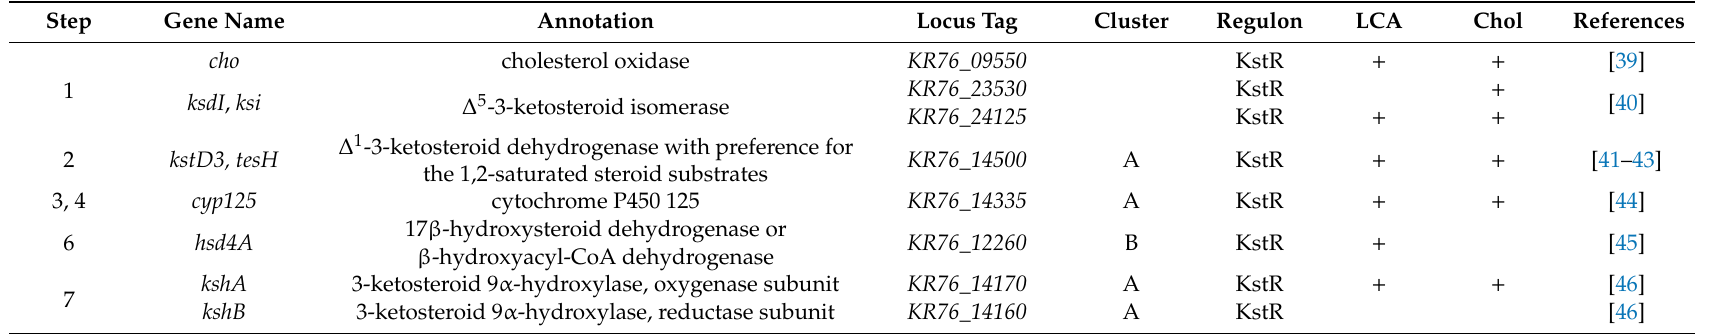
Table 3. Genes involved in the initial steps of steroid oxidation in N.